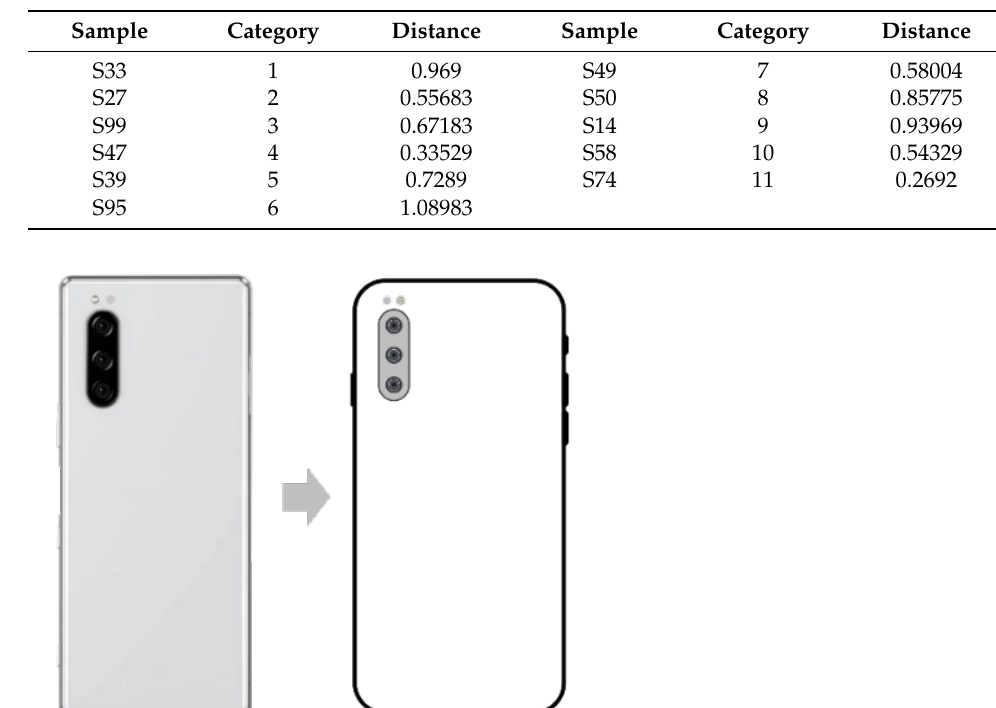
Table 4. The results of cluster analysis.